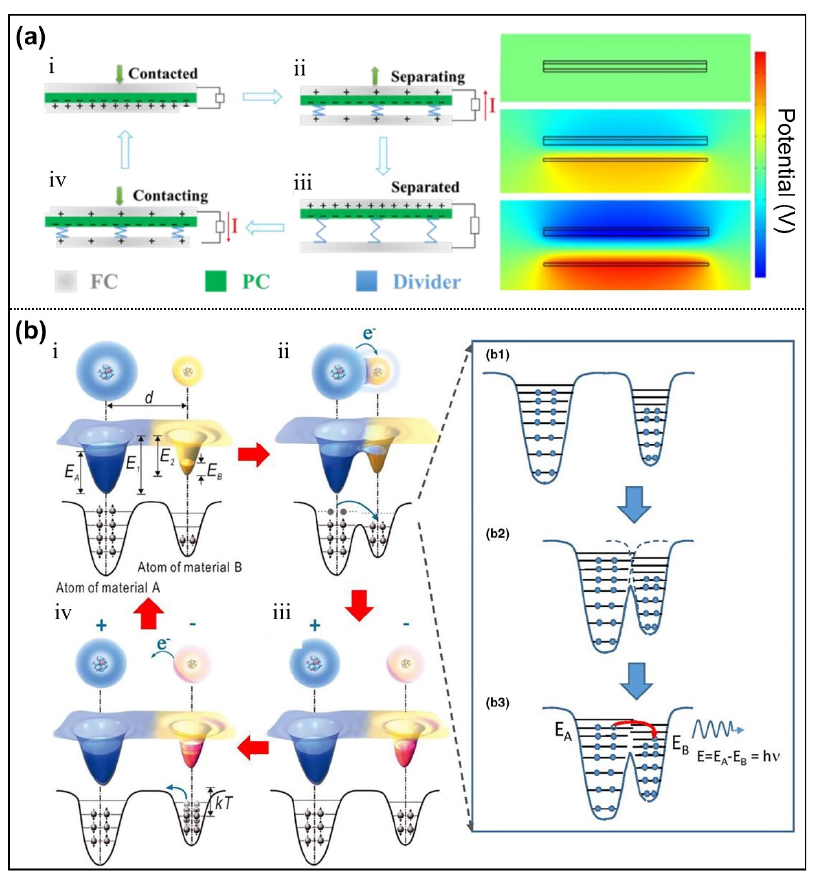
Figure 2. Working mechanism of TENG. ( a ) Working models, which include: (i) original state, (ii) separating state, (iii) fully separated, (iv) contacting each other. Reprinted with permission from Ref. [35]. Copyright 2020 American Chemical Society. ( b ) The electron cloud/potential well mechanism for the contact ‐ electrification phenomenon. Reprinted with permission from Ref. [31]. Copyright 2022 Elsevier.